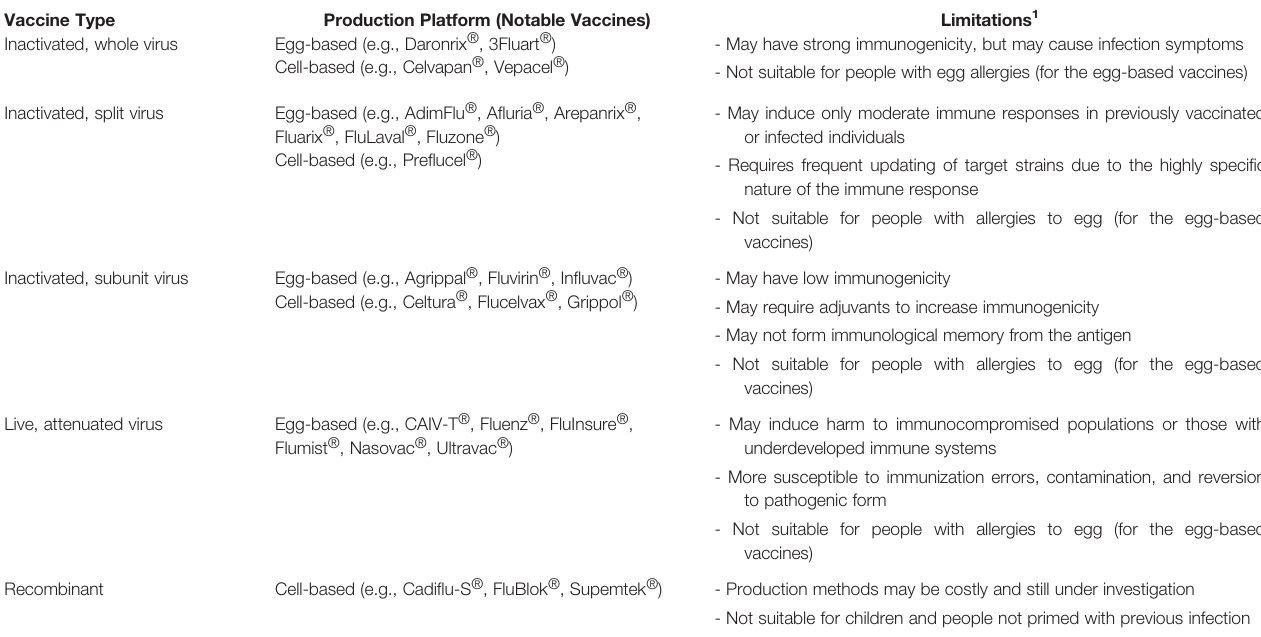
TABLE 1 | General characteristics and notable examples of in fl uenza vaccines licensed for use against seasonal or pandemic in fl uenza, categorized based on their type and production platform. Vaccine